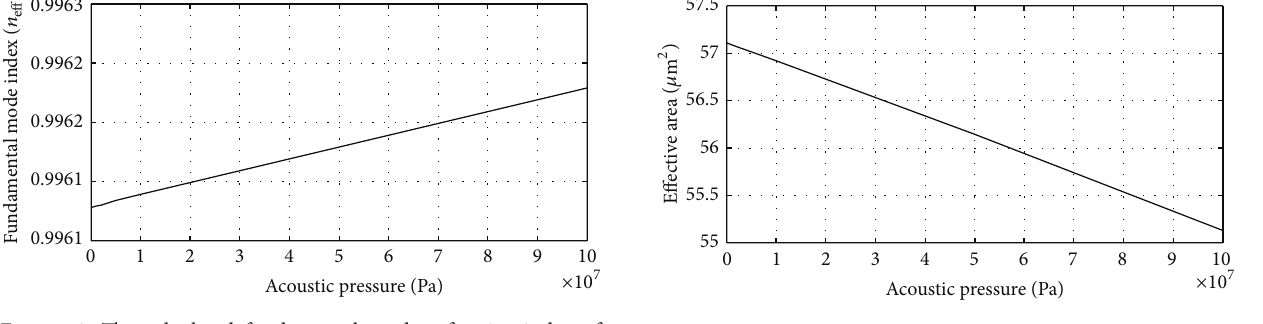
Figure 5: The calculated effective area of the investigated HC-PBF as a function of the acoustic pressure at acoustic frequency 10 kHz.